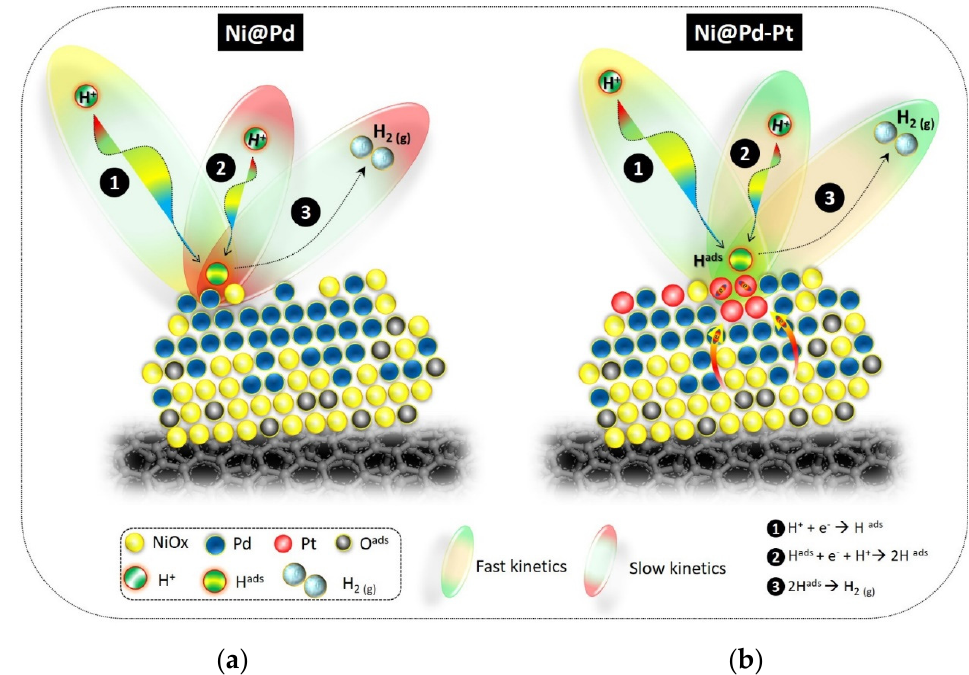
NC, Figure S3: Stability test results of Ni@Pd-Pt NC, Figure S4: Cyclic voltammograms of experimental NCs, Table S1: ICP-OES determined composition ratios of experimental NCs, and Table S2: Benchmark Table for HER activity of Pt-based